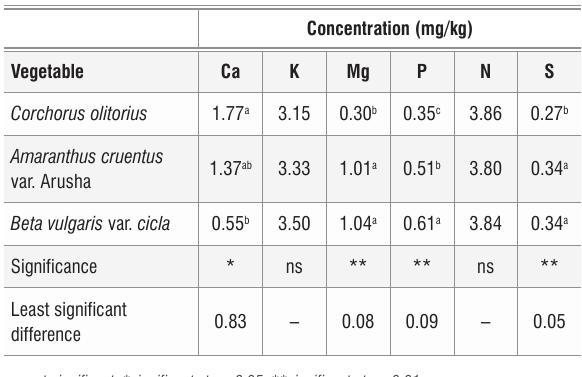
Macronutrient composition of three vegetable species in response to micronutrient fertiliser added to